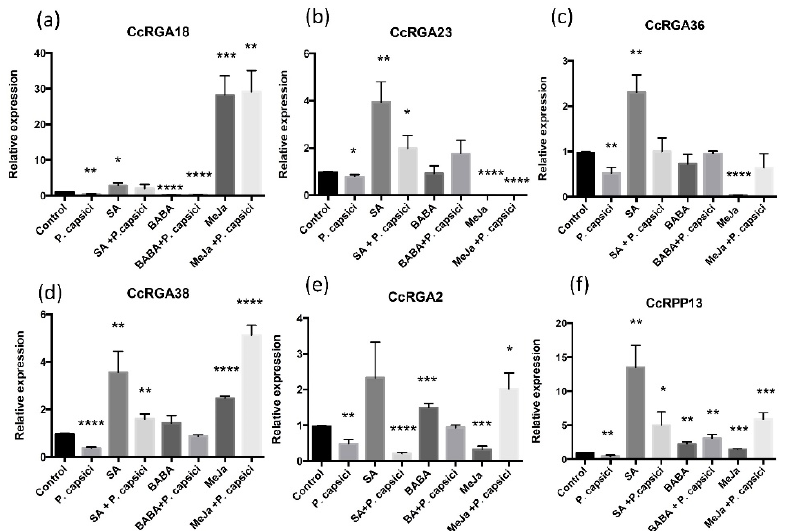
Figure 5. Relative expression of the genes CcARGA in plants of C. chinense when are applied an elicitors treatment and challenged with P. capsici : CcRGA18 ( a ), CcRGA23 ( b ), CcRGA36 ( c ), CcRGA38 ( d ), CcRGA2 ( e ), and CcRPP13 ( f ). The data represented means of triplicate biological and experimental repeats; error bars represented SEM. The asterisk indicates statistically significant differences between treatments (range test p < 0.05).